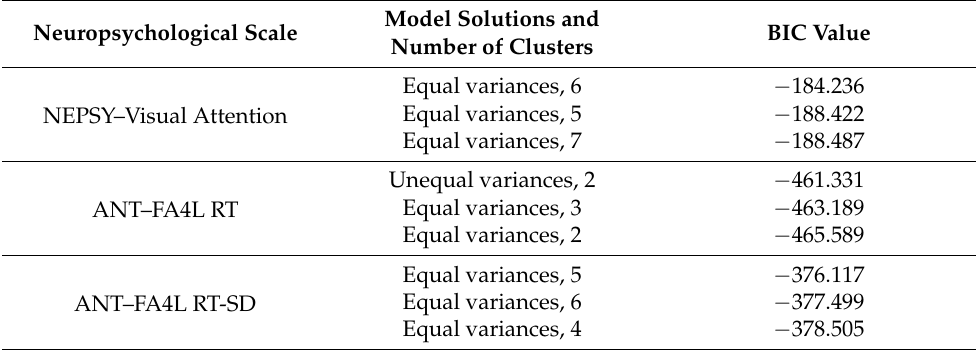
Table A2. Top three FGMMs based on the BIC criterion (neuropsychological variables). The model that was selected as best is